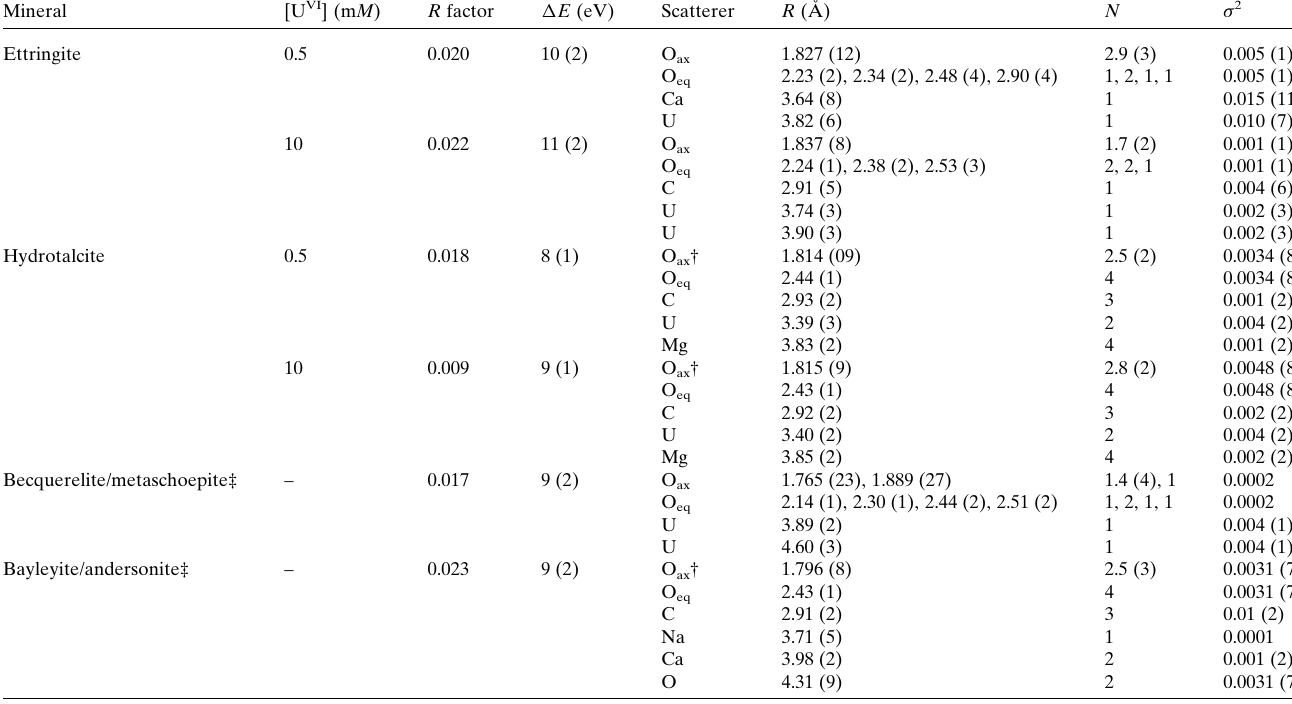
Table 5 EXAFS model parameters for U VI -contacted ettringite and hydrotalcite minerals and mixed becquerelite/metaschoepite and bayleyite/andersonite mineral